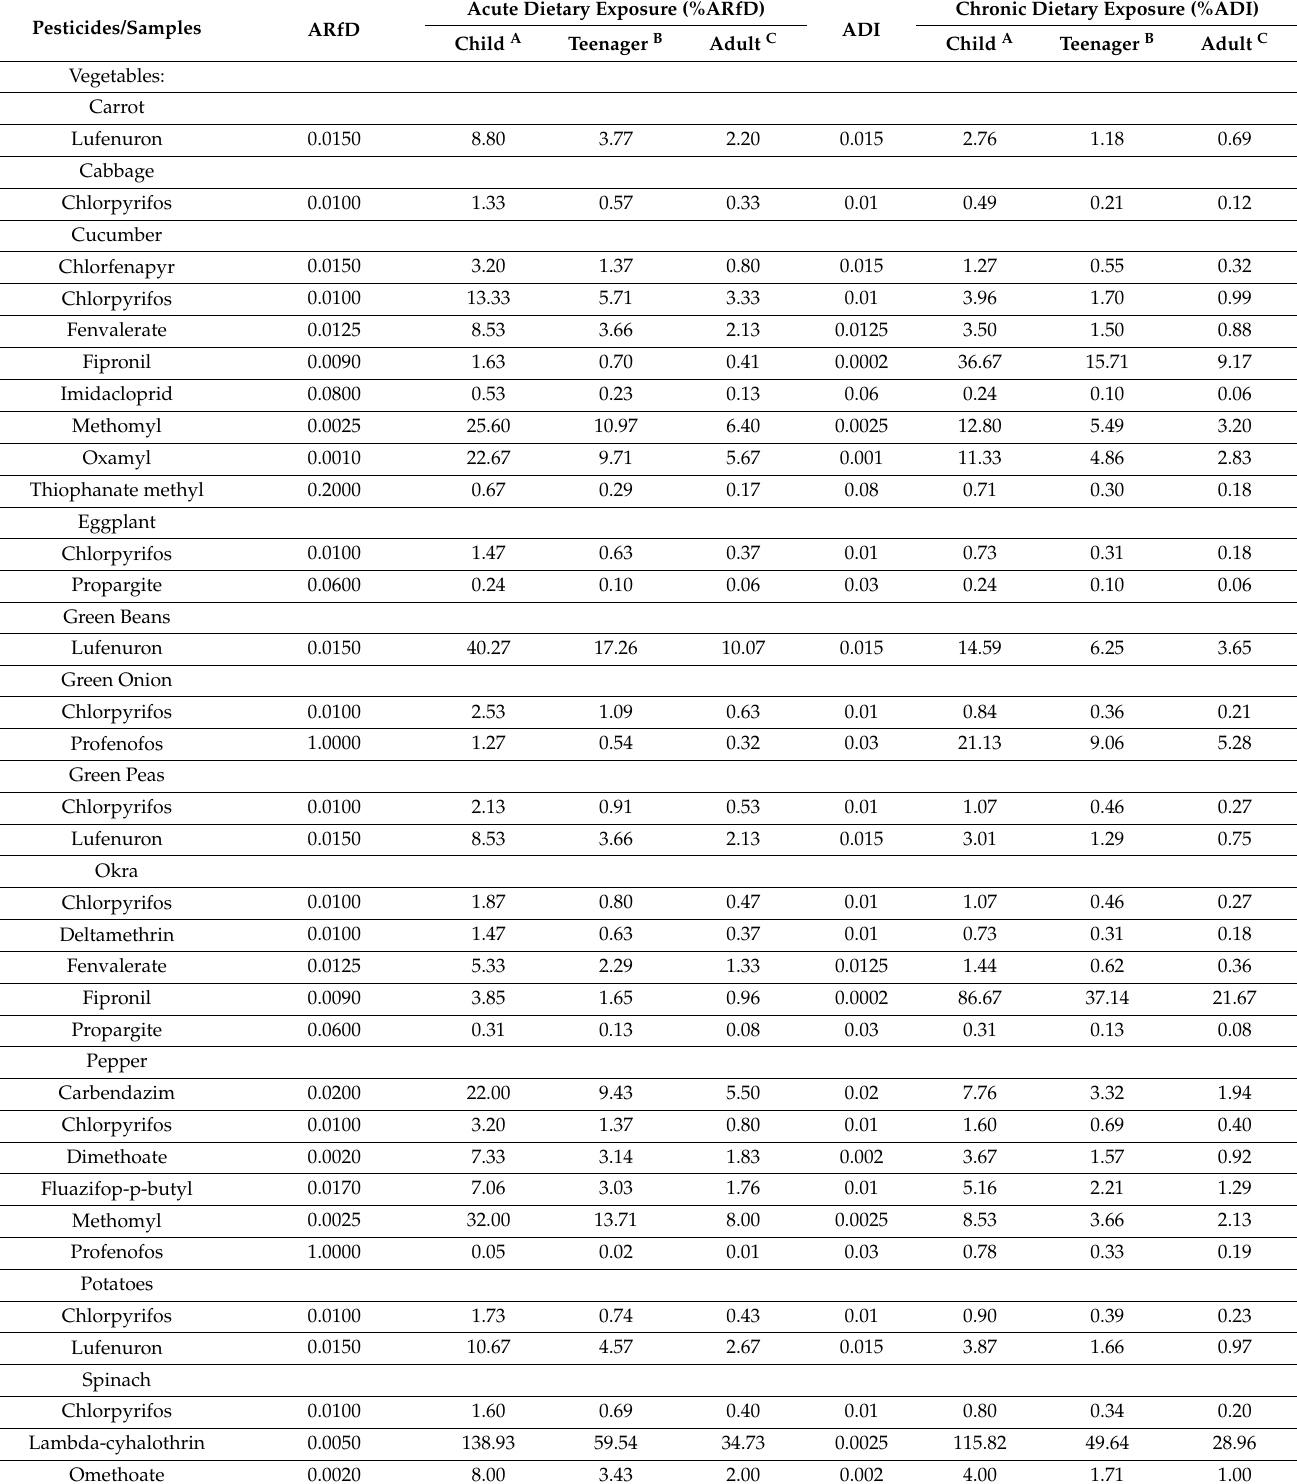
Table 3. Acute (% ARfD) and chronic (% ADI) risk assessment of pesticide residues in vegetable and fruit samples exceeding maximum residue levels using two consumption rates (0.1 kg for chronic risk and 0.2 kg for acute risk) in different population